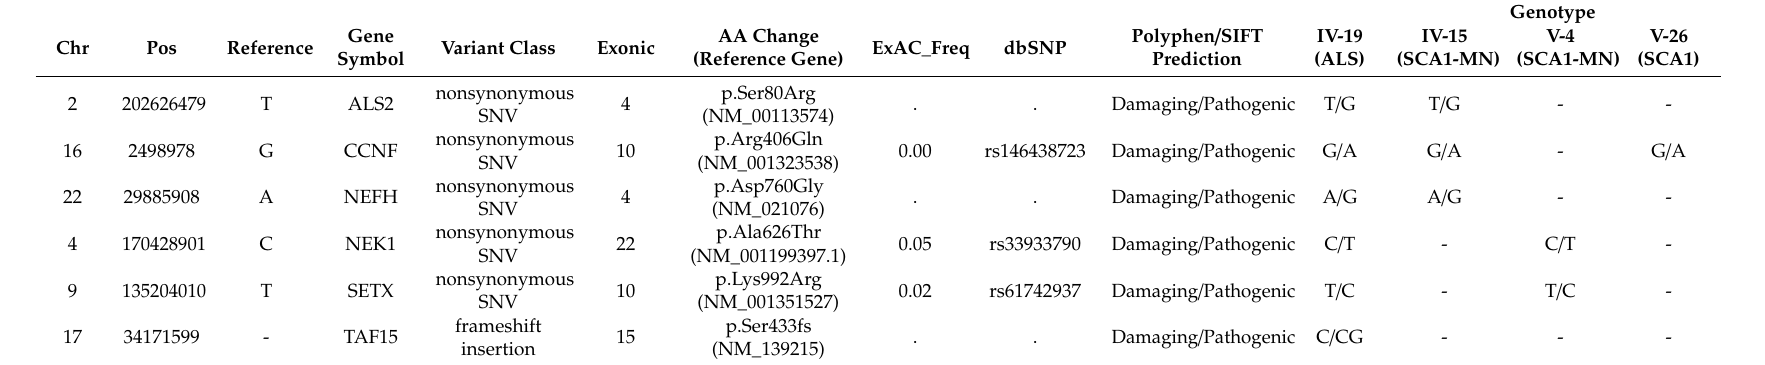
Table 1. Potential pathogenic variants identified in the ALS patient by targeted panel